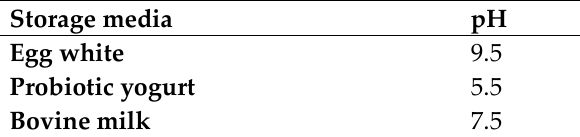
Table 1: pH values of the storage